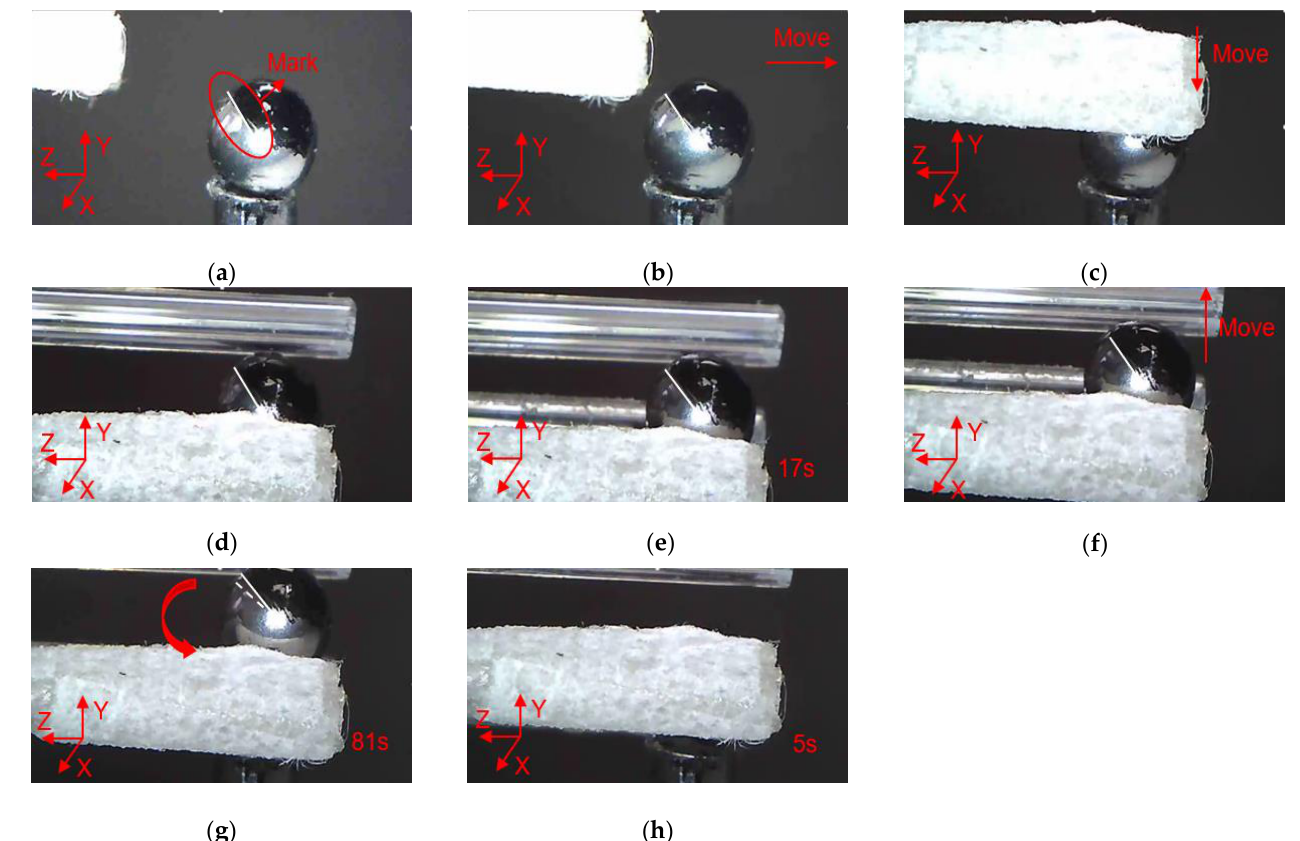
Figure 15. Manipulation of a micro ball: ( a ) Initial state; ( b ) Microgripper is moved to approach the micro ball; ( c ) The microgripper is moved downward to approach the micro ball; ( d ) The microgripper is reached to the clamping position; ( e ) The micro ball is clamped; ( f ) The micro ball is move upward; ( g ) The micro ball is rotated about axis X; (h) The micro ball is released.